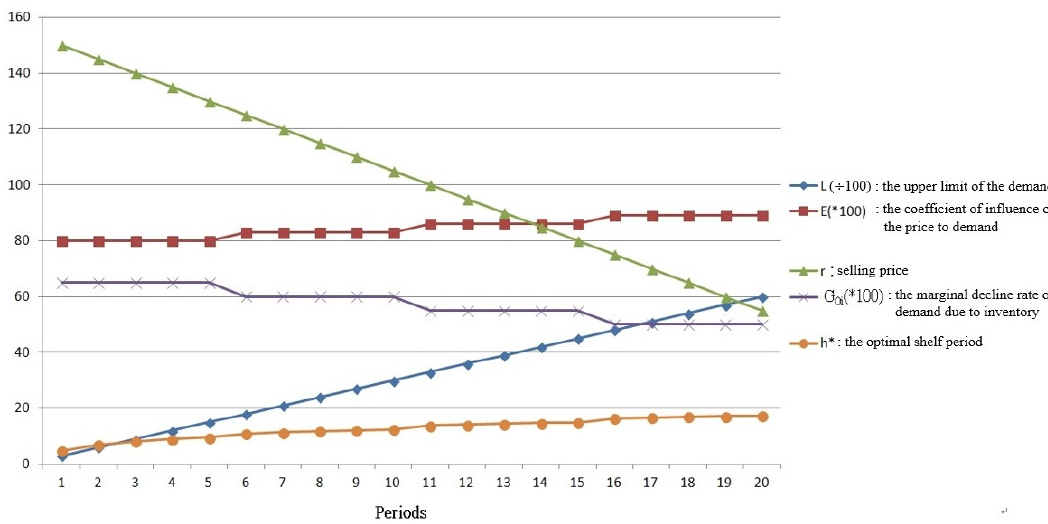
Figure 3. Influence of relevant parameters on commodity